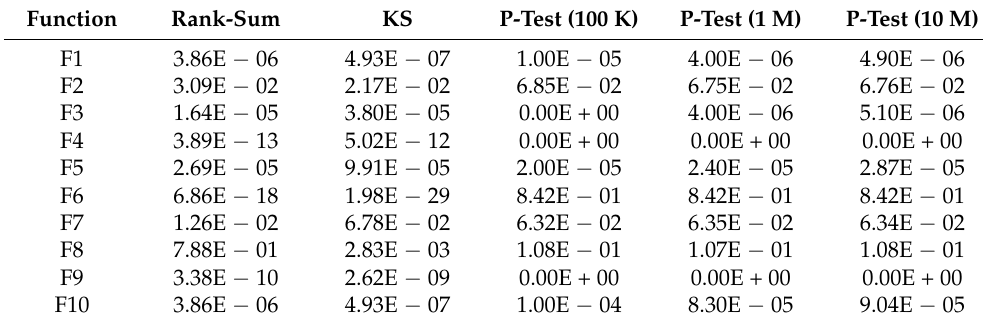
Table 10. The p -values obtained from Wilcoxon rank-sum, KS, and permutation tests when comparing HBA and JS. When α = 0.05, the results for the tests are generally consistent, except for F2, F6, F7, and F8. On these functions, the P-Test is the most conservative